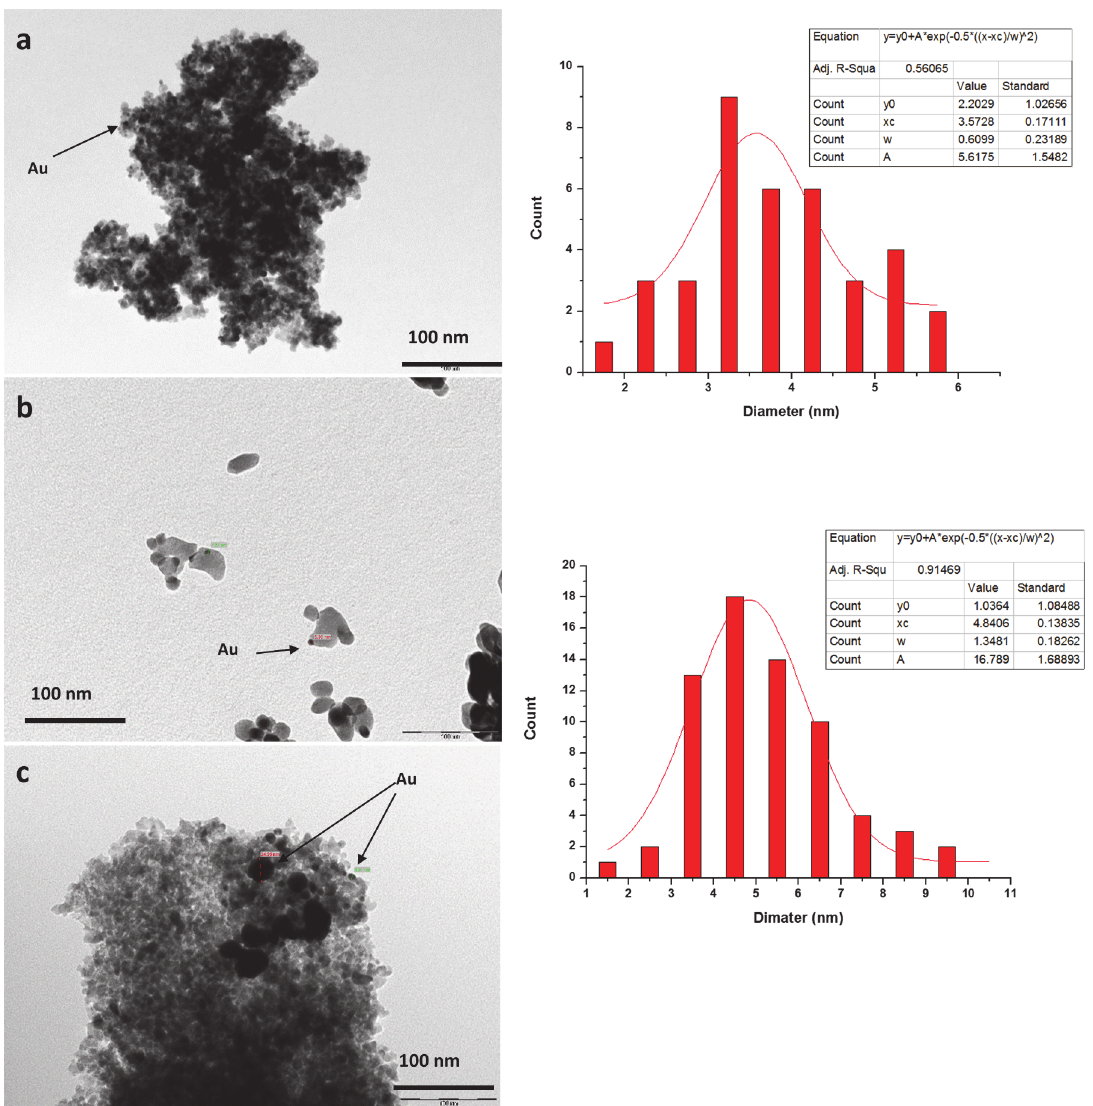
Figure 5. TEM images for ACePVA (section a ); AZrPVA (section b ) and ATiPVA (section c ).